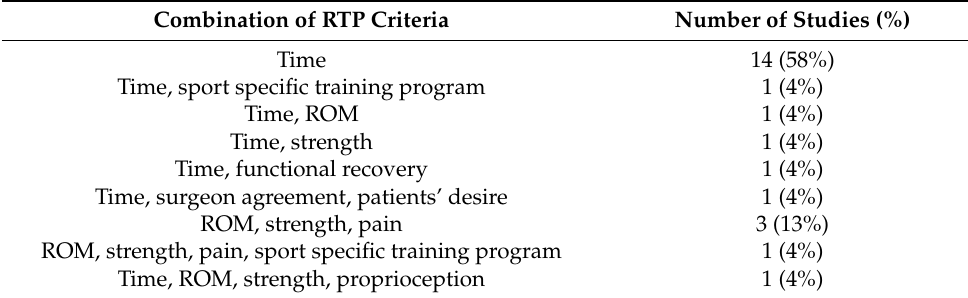
Table 3. Combinations of RTP criteria among included